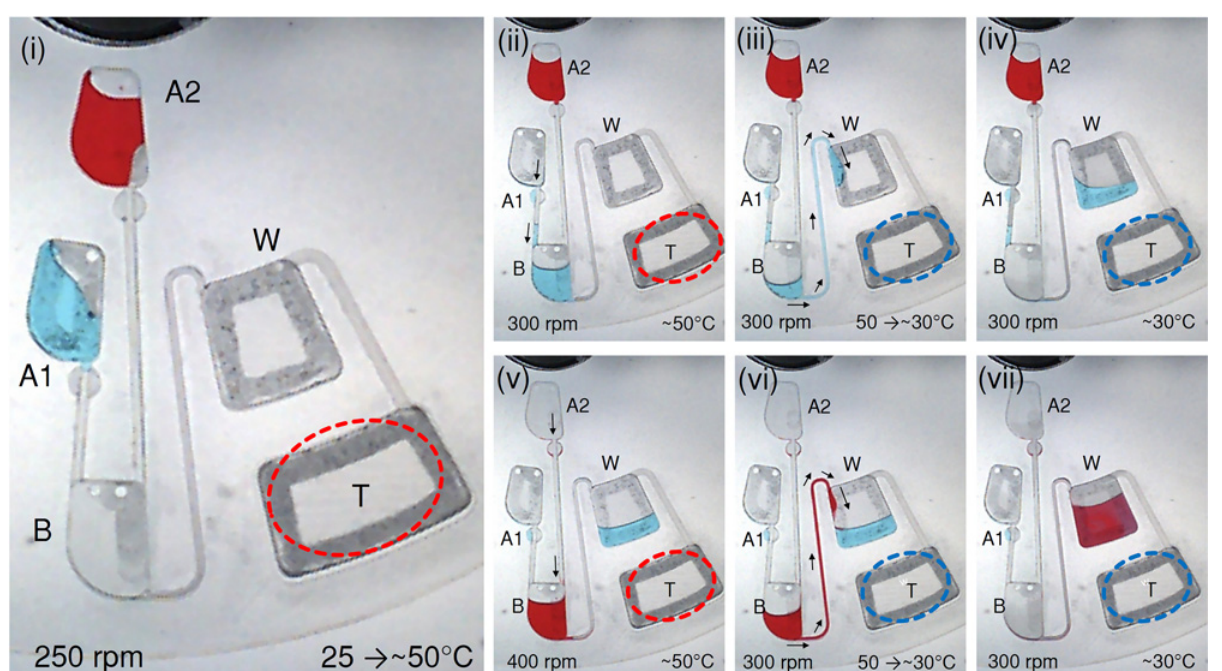
Fig 4. Demonstration of sequential biosensor chamber pull-evacuation: (i) Blue and Red liquids are loaded into source chamber A1 and A2. (ii — iv) Blue liquid bursts from source chamber A1 into biosensor chamber B, then pull-evacuated into waste chamber W. (v — viii) Sequentially Red liquid bursts from source chamber A2 into biosensor chamber B, then pull-evacuated into waste chamber